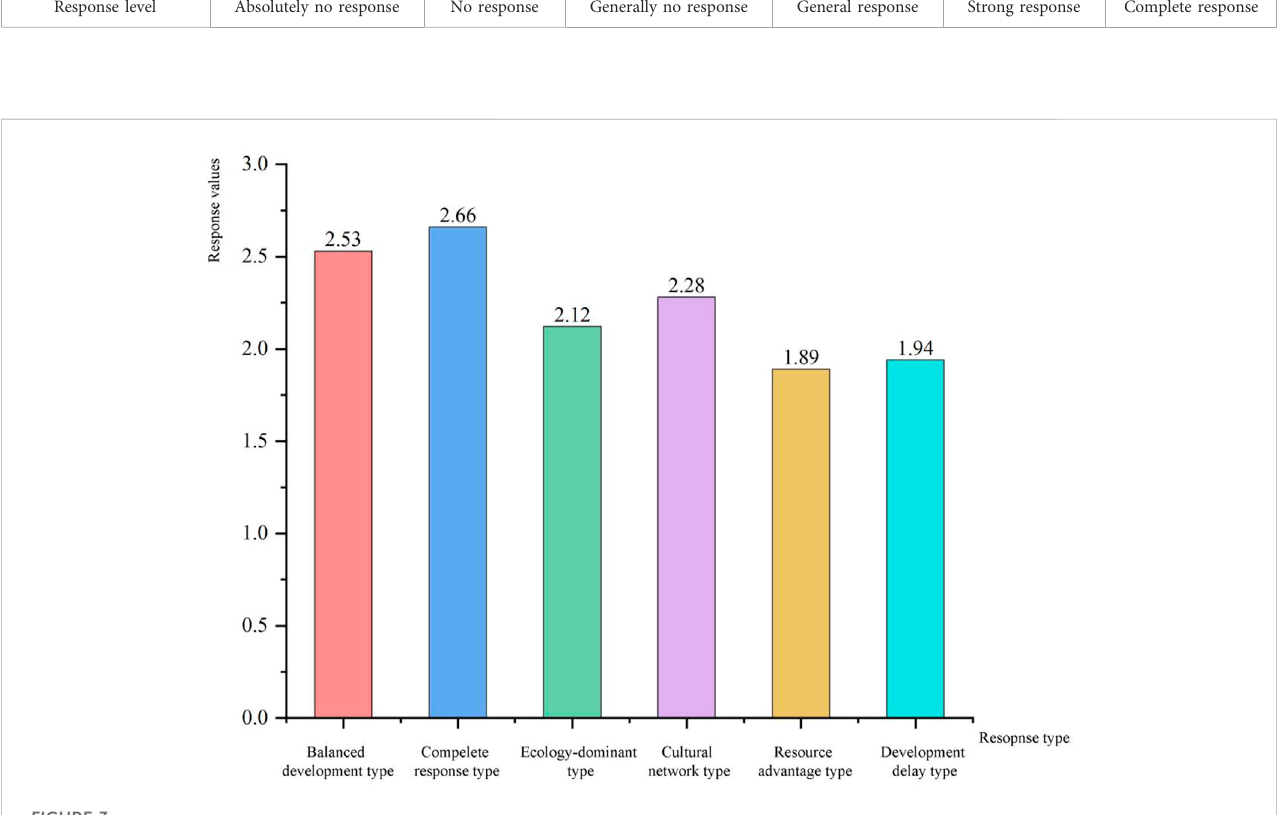
Overall responsiveness for the six types of farmers ’ sustainable livelihood response